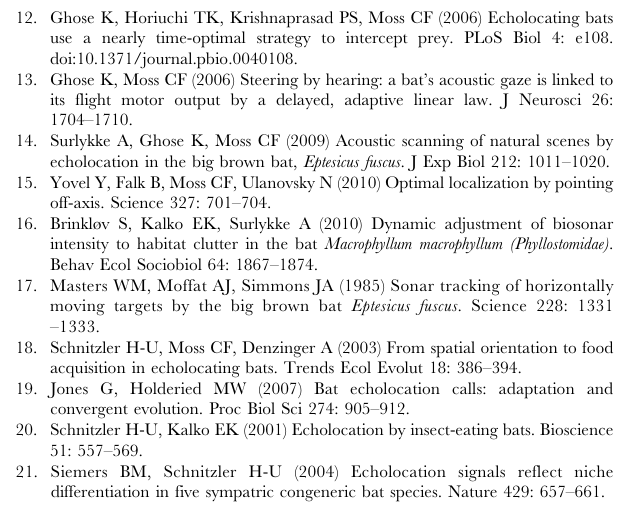
Figure S2 The inter-click angle increases with the increase in environmental complexity, in all individual bats. Notice that the basal angle differs between individual bats. ‘‘0,’’ no object; ‘‘1,’’ one object; ‘‘5,’’ multiple-object (five-objects) experiments. Error bars, mean 6 s.e.m. Figure S3 The distribution of pulse intervals is bi-modal and is similar across the different experimental settings. The two peaks in the histogram represent the inter-pair intervals (right peak) and intra-pair intervals (left peak). In the no-object experiments (light gray), the inter-pair intervals were slightly higher than in the other setups, and increased from , 90-ms to ,